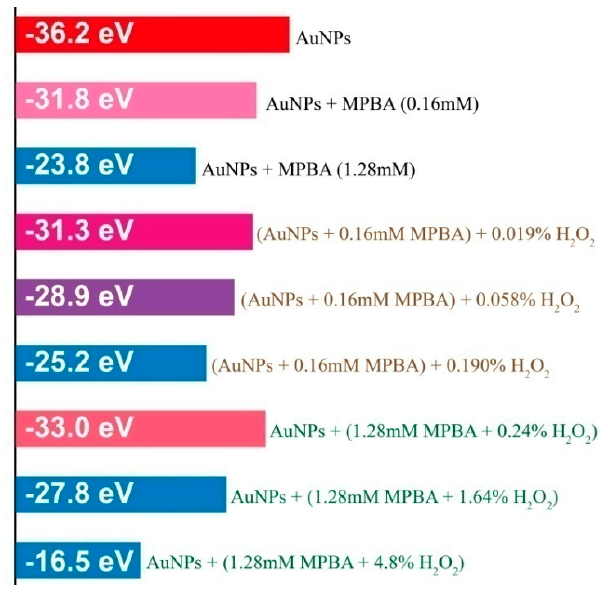
Figure 2. Zeta ‐ potentials for the solutions formed by a given amount of citrate ‐ capped AuNPs mixed Figure 2. Zeta-potentials for the solutions formed by a given amount of citrate-capped AuNPs mixed with different amounts of 4 ‐ MPBA and H 2 O 2 . with di ff erent amounts of 4-MPBA and H 2 O 2